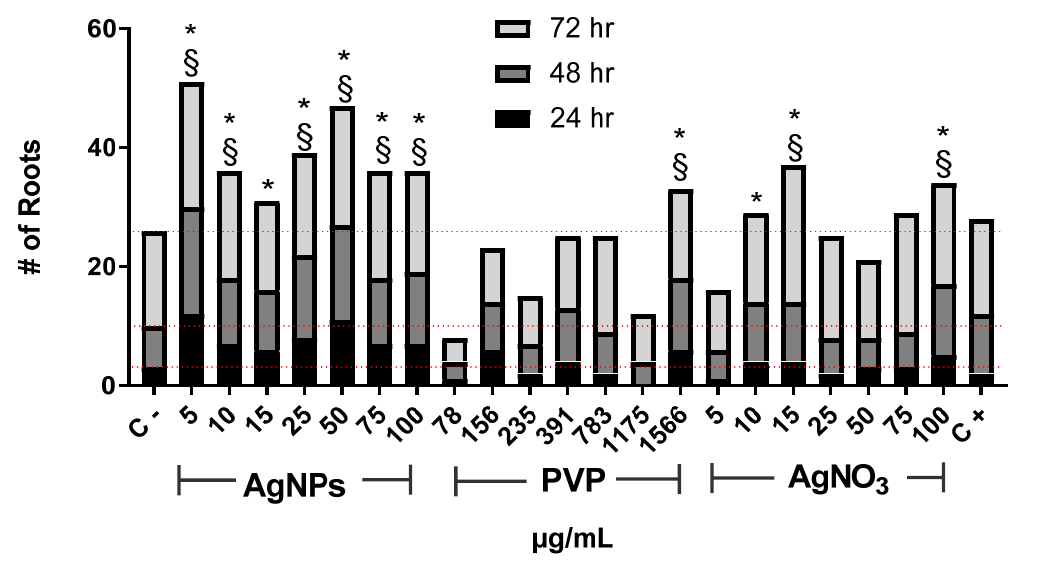
Figure 2. The number of new roots counted on Allium cepa exposed to AgNPs, PVP, and AgNO 3 with di ff erent concentrations after 24 (black), 48 (dark gray), and 72 h (gray) of exposure. Negative control (C − ) was distilled water. 0.37 µ g / mL of sodium arsenite was used as a positive control (C + ). Red dotted lines were included for comparative purposes that show the number of roots observed for negative control on each evaluated time. * Indicates significative di ff erences with the negative control ( p < 0.05); § indicates significative di ff erences with the positive control (p < 0.05) after 72 h of exposure.